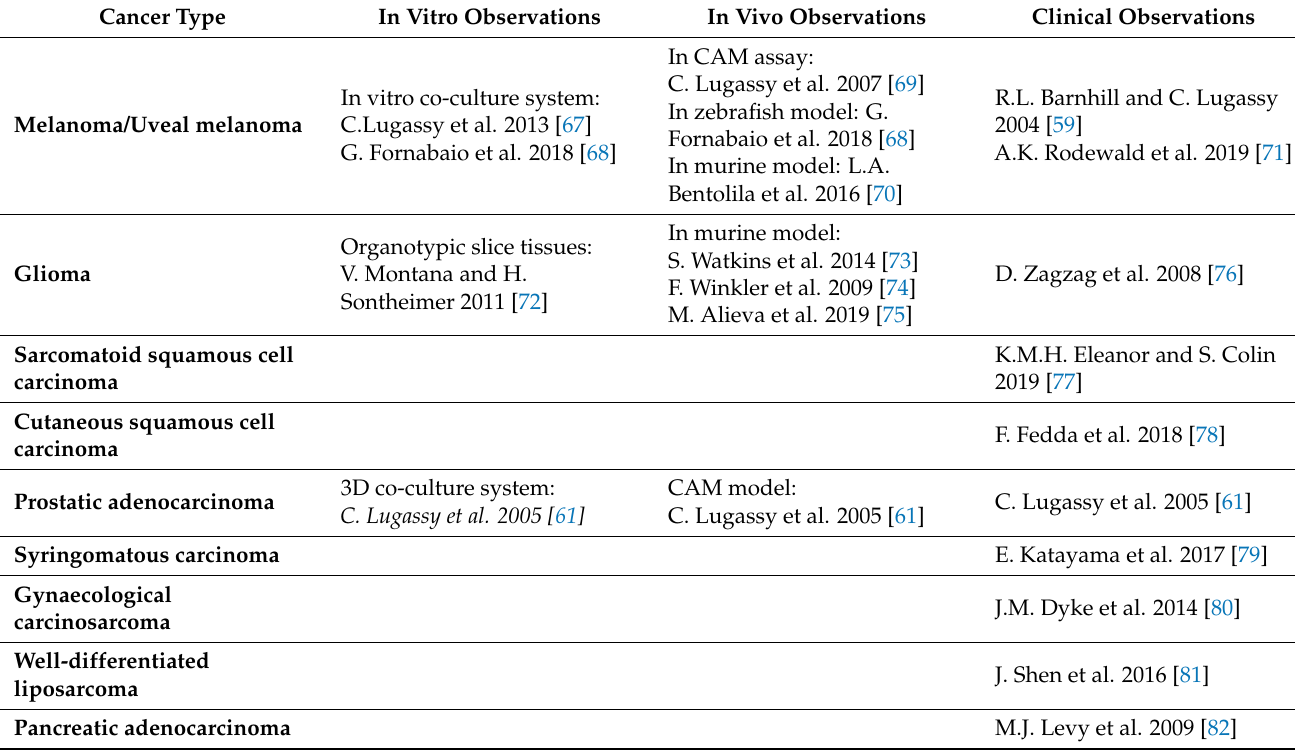
Table 2. Cancer types displaying perivascular